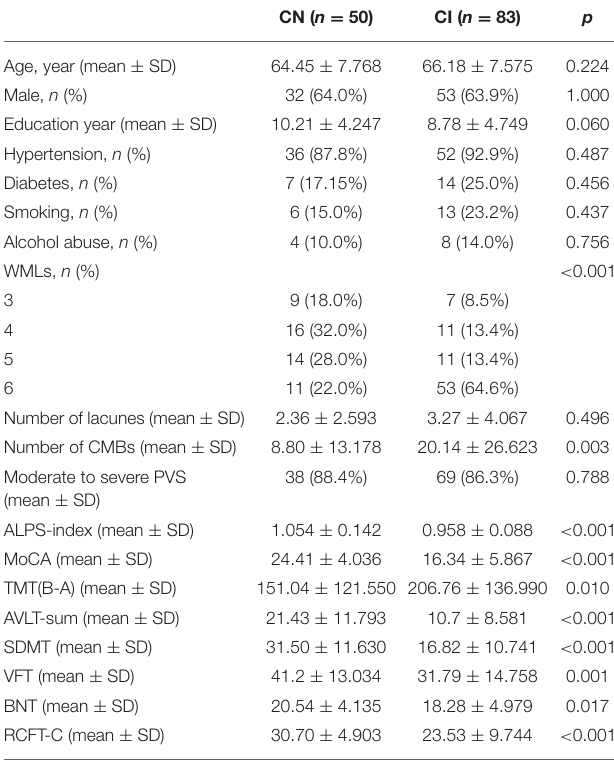
TABLE 1 | Demographics, imaging and cognitive condition of